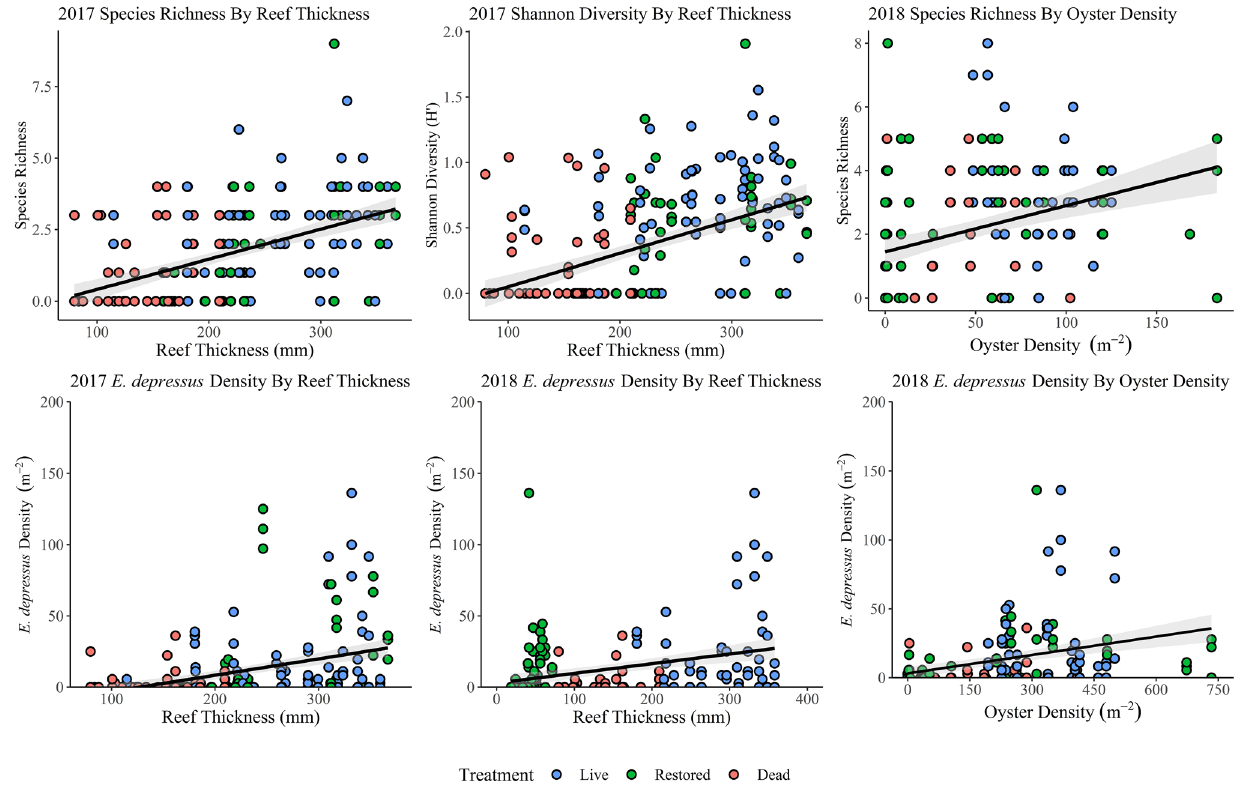
Figure 3. Scatterplots showing meaningful correlations between species diversity and abundance. Species diversity and abundance of Eurypanopeus depressus was significantly correlated with oyster reef thickness and oyster density. In general, these oyster habitat metrics increased from dead to restored to live